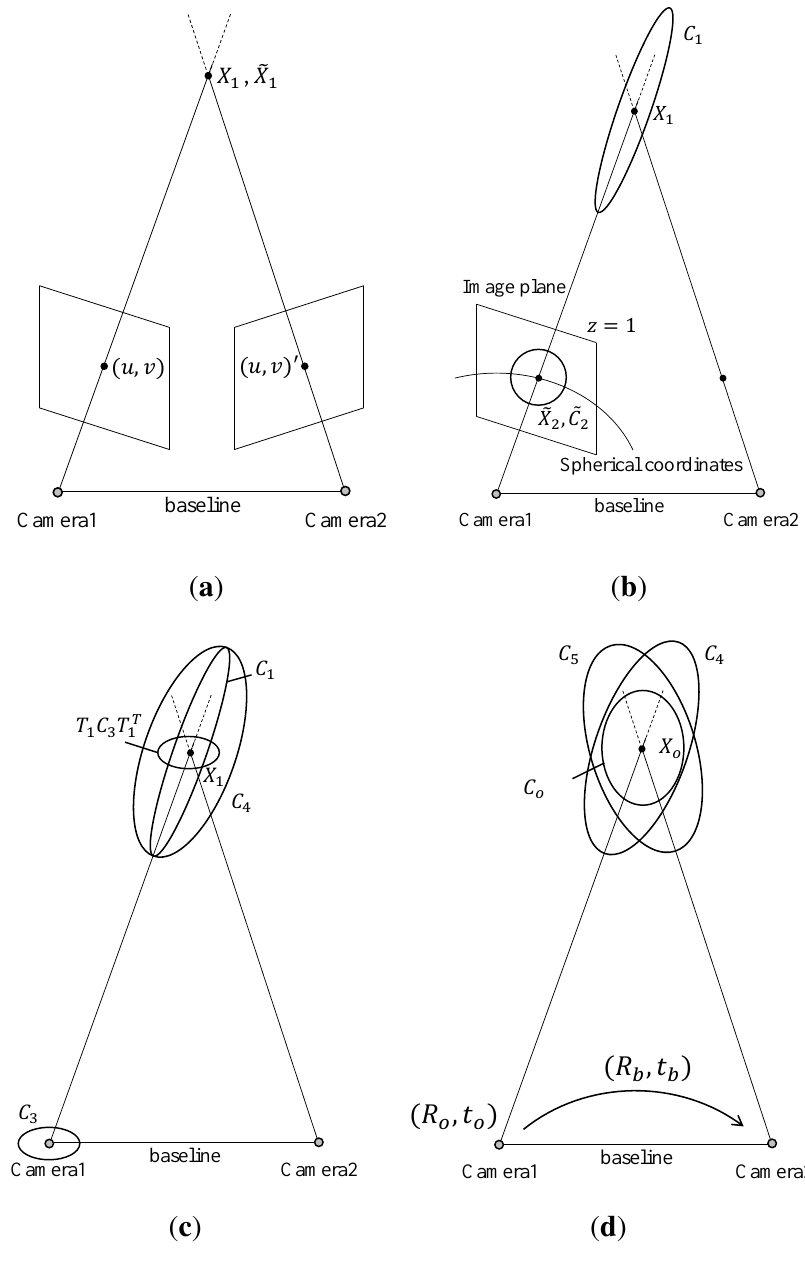
Figure 1. Generation steps of probabilistic features in a stereo system. ( a ) Matched feature points on each image plane; ( b ) Conversion from Cartesian coordinate to spherical coordinate system; ( c ) Estimating covariance from a single camera; ( d ) Estimating initial covariance of the stereo system by merging covariance of each